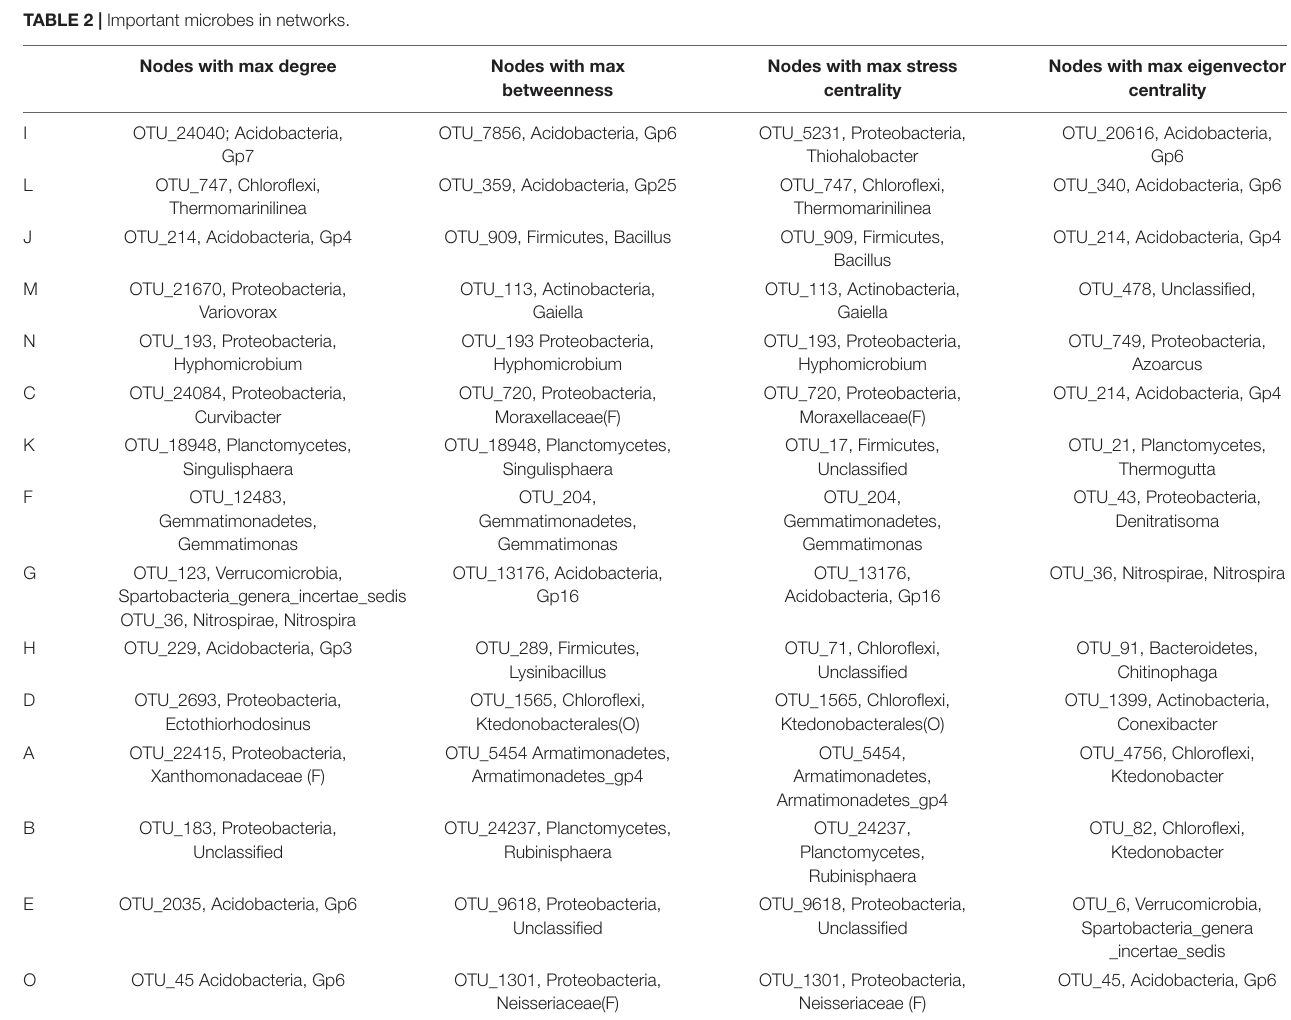
TABLE 2 | Important microbes in networks. Nodes with max degree Nodes with max